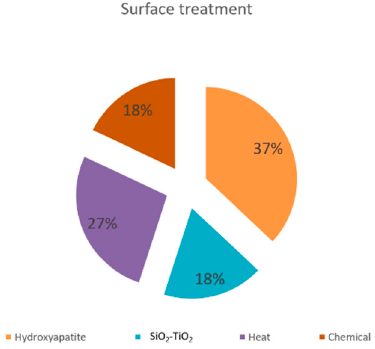
Figure 7. Synthesis of surface coating and treatment on bone ingrowth results.